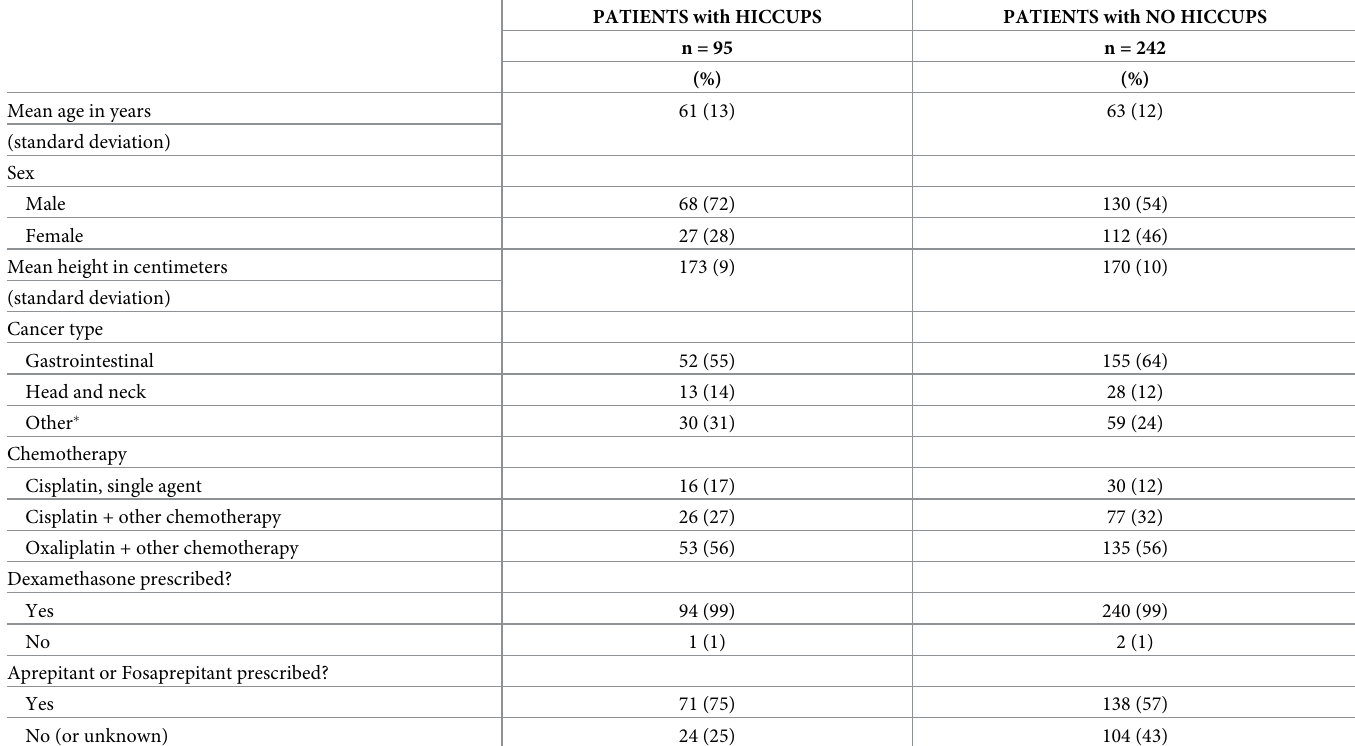
Table 1. Demographics and other baseline factors; n = 337.